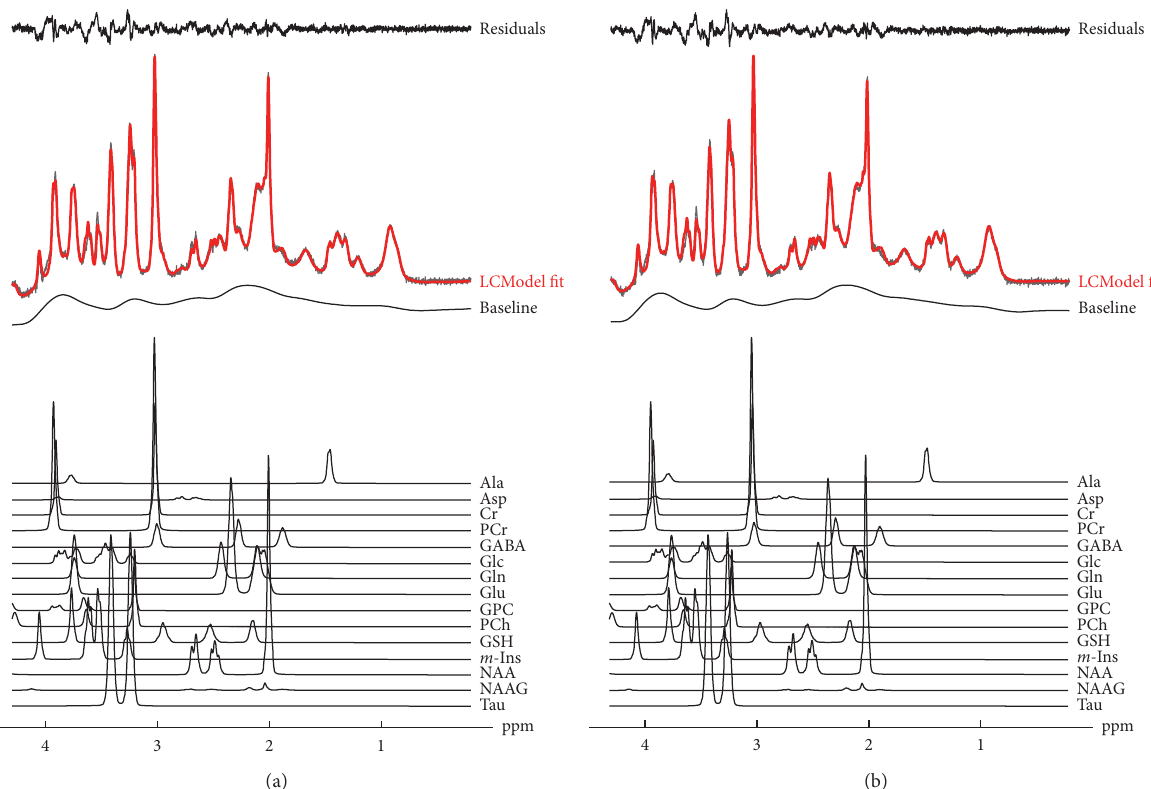
Figure 2: Averaged 1 H-MRS raw data (transparent black) and LCModel fit (red) measured from the mouse hippocampus at 9.4T Bruker MRI: (a) control and (b) stress. The residuals (top) were the difference between the raw data and the LCModel fit. The baseline (middle) and each metabolite (bottom) constituting the raw data were represented in the range from 0.2ppm to 4.3